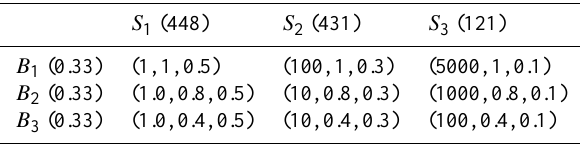
Table 3. Prior parameters for microbial model S3B3. The parameter (cid:16) (cid:17) (cid:16) (cid:17) K S ,ij ,k + ,µ ij , K S ,ij ,k + ,µ ij vectors are presented in the form , whose units ij, 2 ij, 2 are, respectively, gC, d − 1 and none. All values are adapted from Moorhead and Sinsabaugh (2006). All three respiratory coefficients (i.e., γ j ,j = 1 , 2 , 3 as defined in Eq. (30) are set to 0.03d − 1 . Num- bers in the parentheses following the state variables are their initial values, whose units are gC.